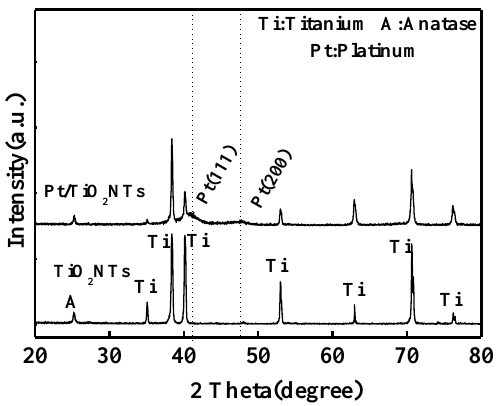
Figure 5. XRD of the Pt-doped TiO